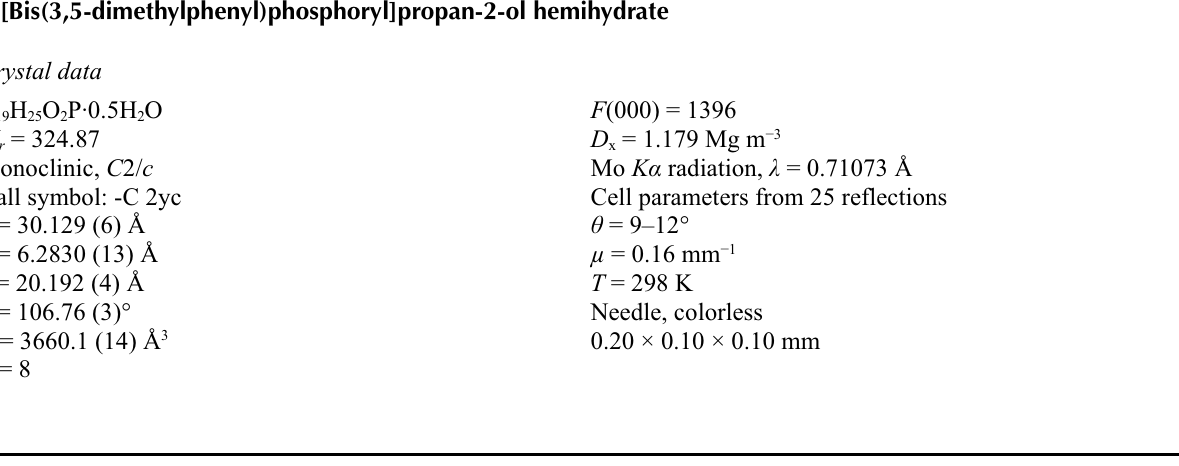
A packing diagram of (I). Hydrogen bonds are shown as dashed lines. 2-[Bis(3,5-dimethylphenyl)phosphoryl]propan-2-ol